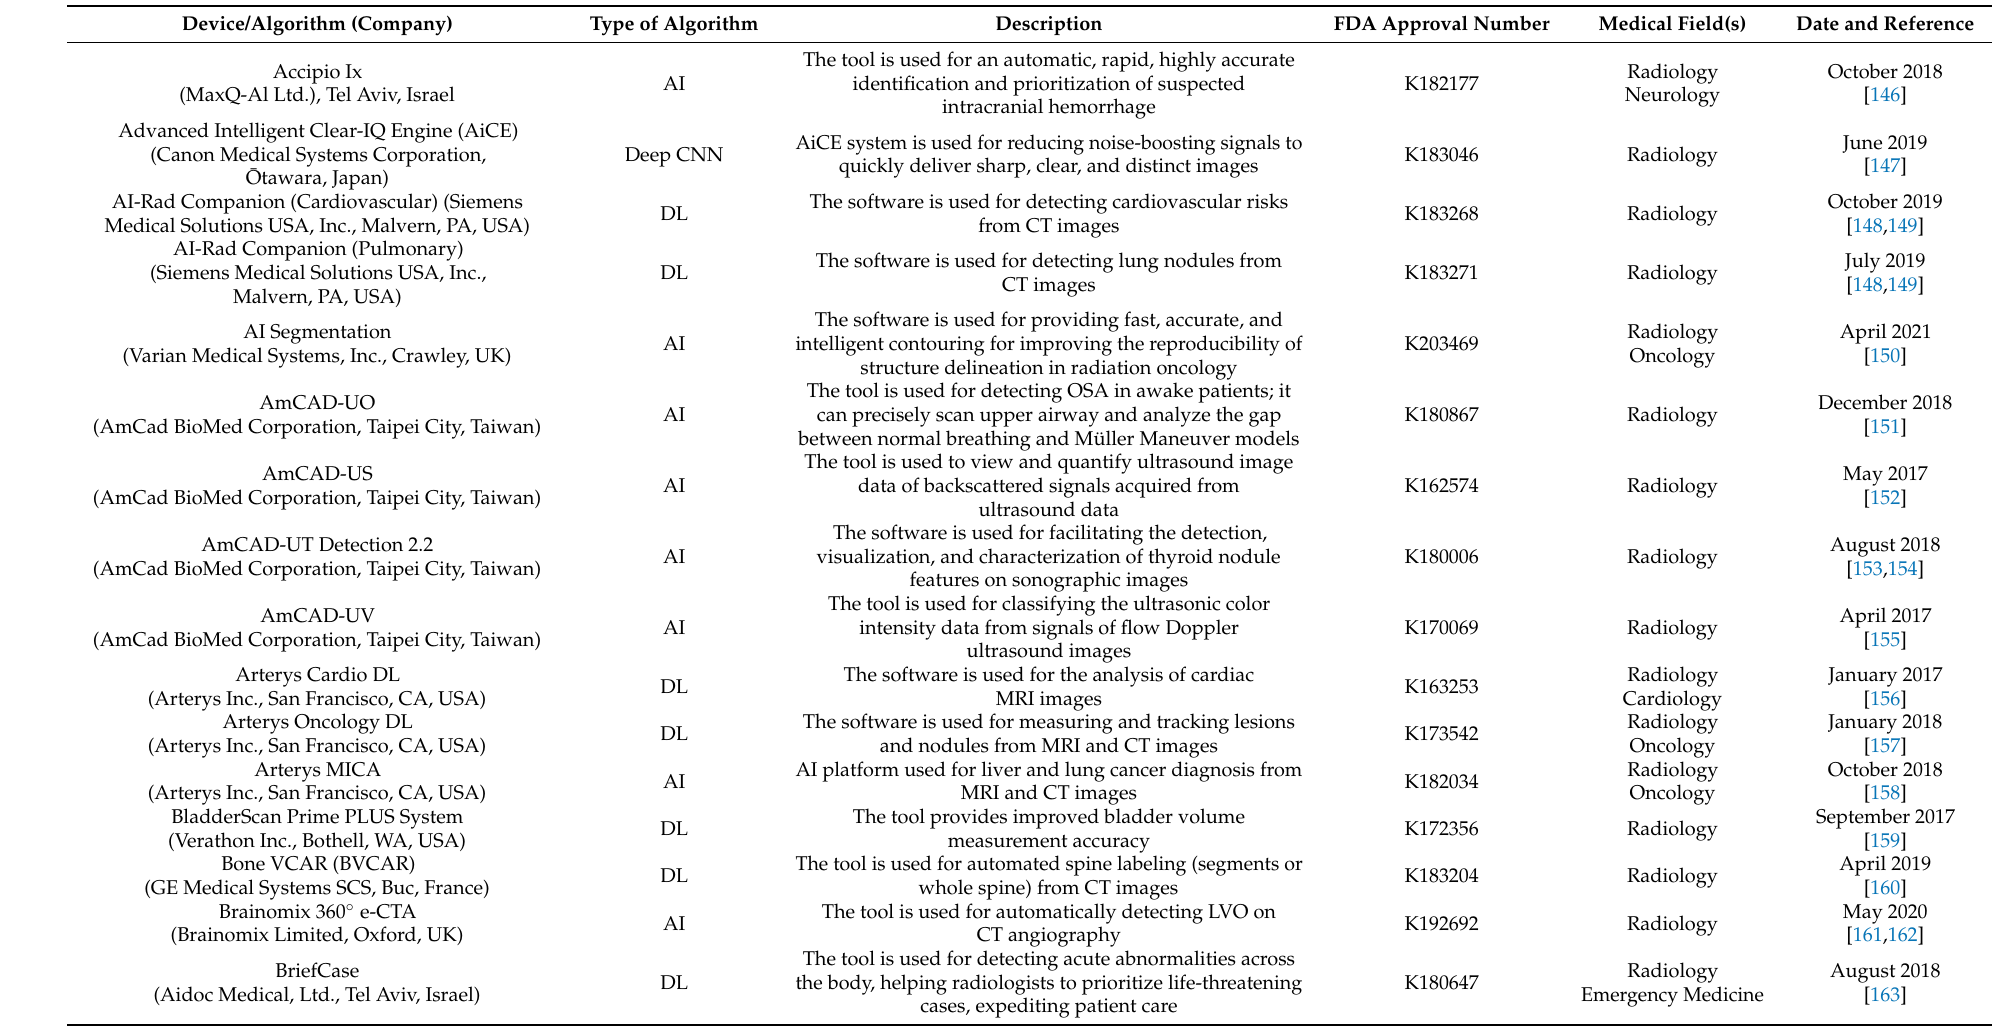
Table 3. List of some examples of FDA-approved AI/ML-based solutions